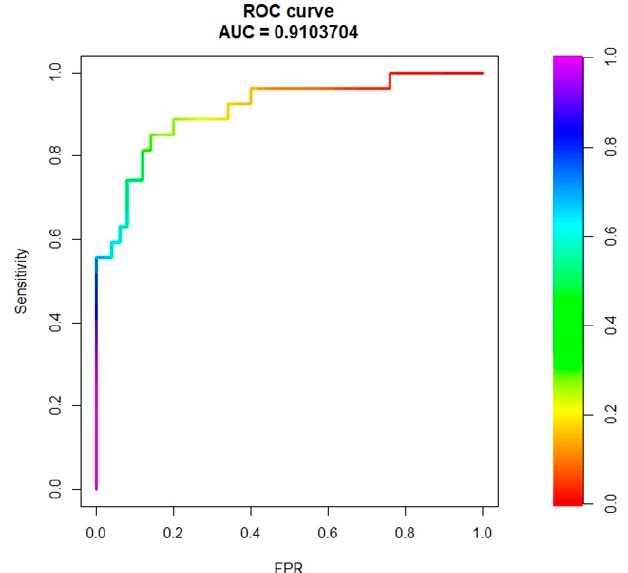
Figure 3. ROC curve analysis referring to the prediction of NRH (no vs. yes), considering clinical, laboratory, and radiomic variables for model training.